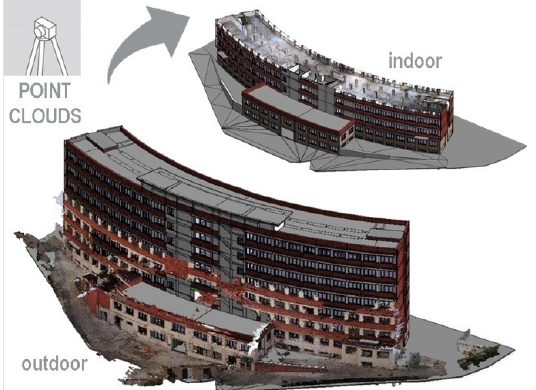
Figure 5: Point clouds imported into Autodesk Revit environment.